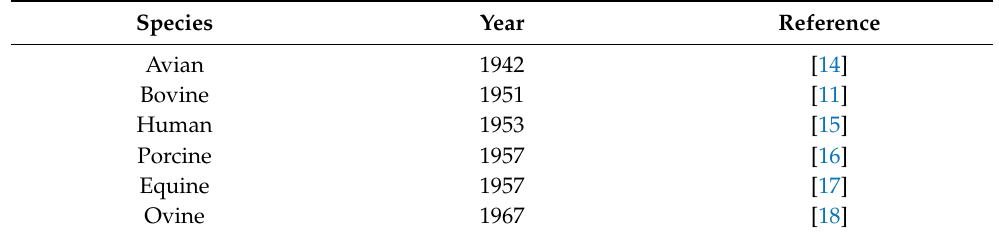
Table 1. First recorded offspring produced via AI using frozen–thawed semen in different